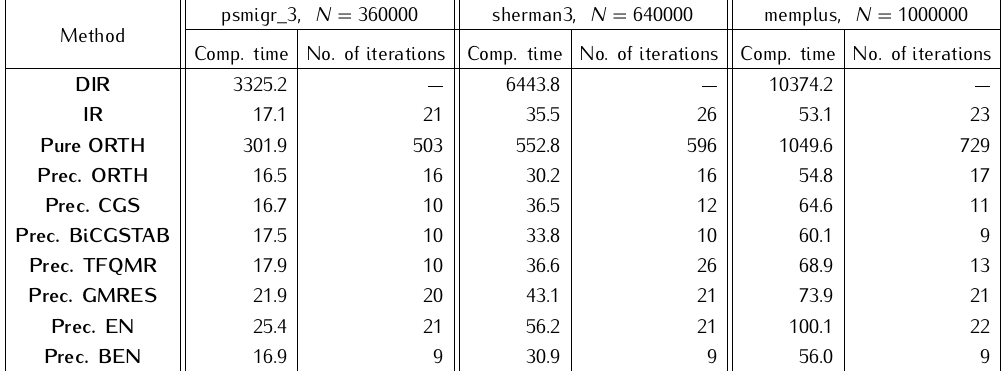
Table 18. Computing times obtained when three matrices produced by the matrix generator with N right-hand side vector b is produced by using x q = 1 , q = 1 , 2 ,...,N , and when ACCUR = 10 − 10 . The relative drop-tolerance is RELTOL = 2 − 5 .